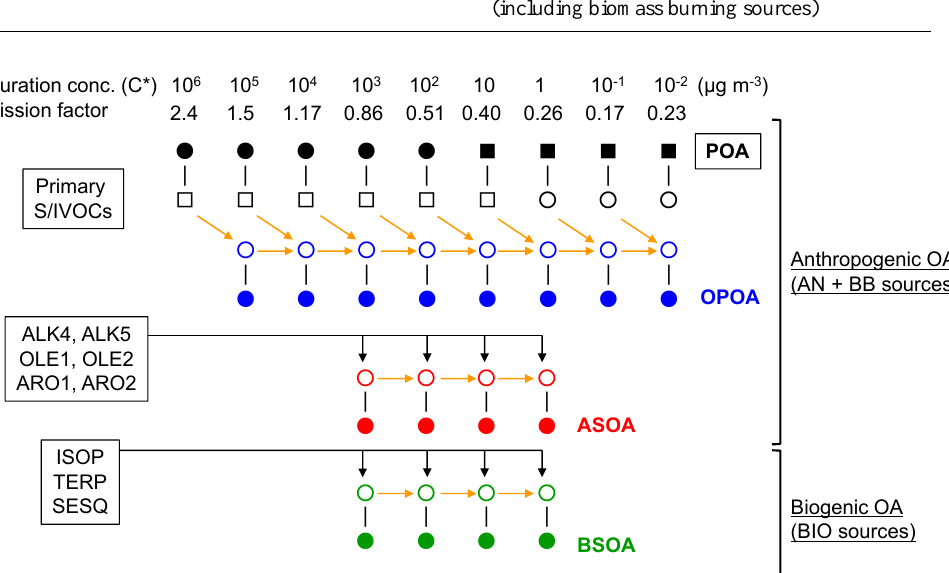
Figure 1. Summary of the volatility basis-set approach used in this study. Circles and squares show individual gas-phase (open) and aerosol- phase (closed) surrogate species. Squares denote primary emission species. AN, BB, and BIO denote anthropogenic, biomass burning, and biogenic sources, respectively. The oxidation processes shown by the black arrows are calculated using the coefficients given by Tsimipidi et al. (2010). The oxidation processes shown by the orange arrows are calculated by assuming OH oxidation with a rate coefficient of 1 × 10 − 11 cm 3 molecule − 1 s − 1